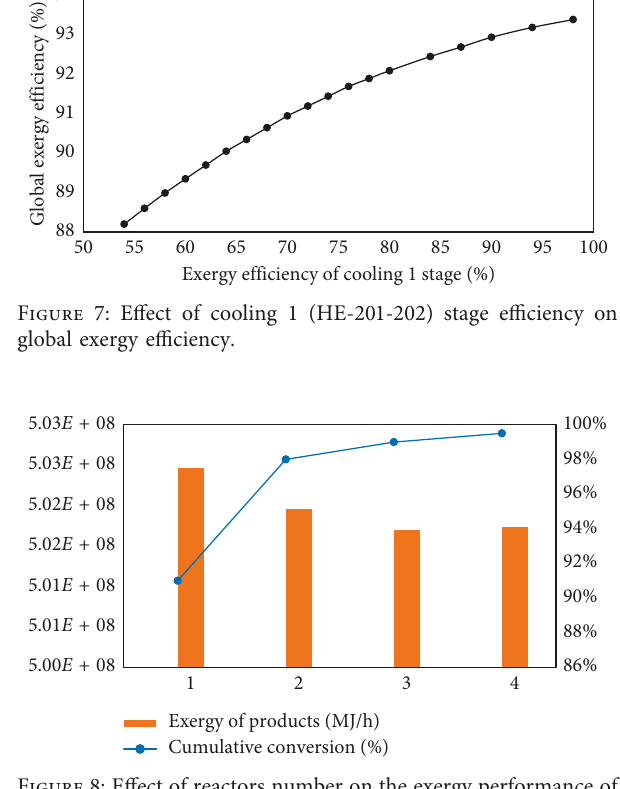
Figure 8: Effect of reactors number on the exergy performance of the polyfunctional reaction 001. 1. E +